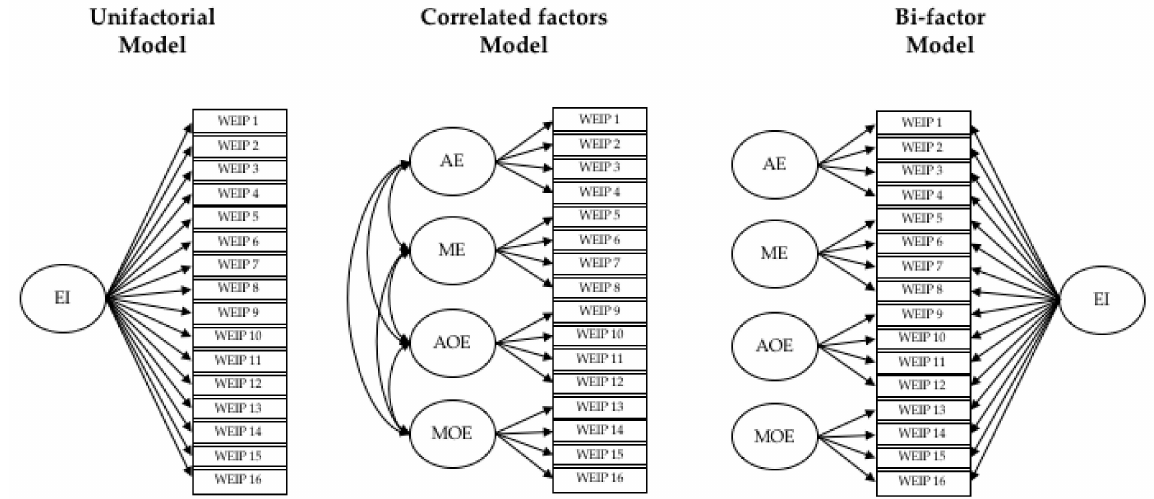
Figure 1. Models tested for Workgroup Emotional Intelligence Profile (WEIP-S). EI, emotional intelligence; AE, aware- ness of own emotions; ME, management of own emotions; AOE, awareness of others’ emotions; MOE, management of others’